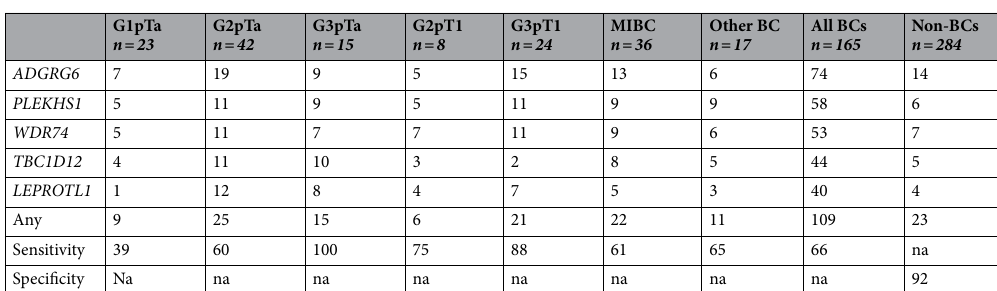
Table 2. Non-coding mutation hotspots in urine cpDNAs across stages and grades of incident BC. The table shows the number of cpDNAs in which a mutation in each gene was detected with > 2% VAF. Other BC = stage or grade unrecorded or CIS (n = 3) or G1pT1 (n = 1). Any = mutation(s) detected in ≥ 1 gene. The non-BCs used in the training set have been excluded. Sensitivity and specificity are shown as